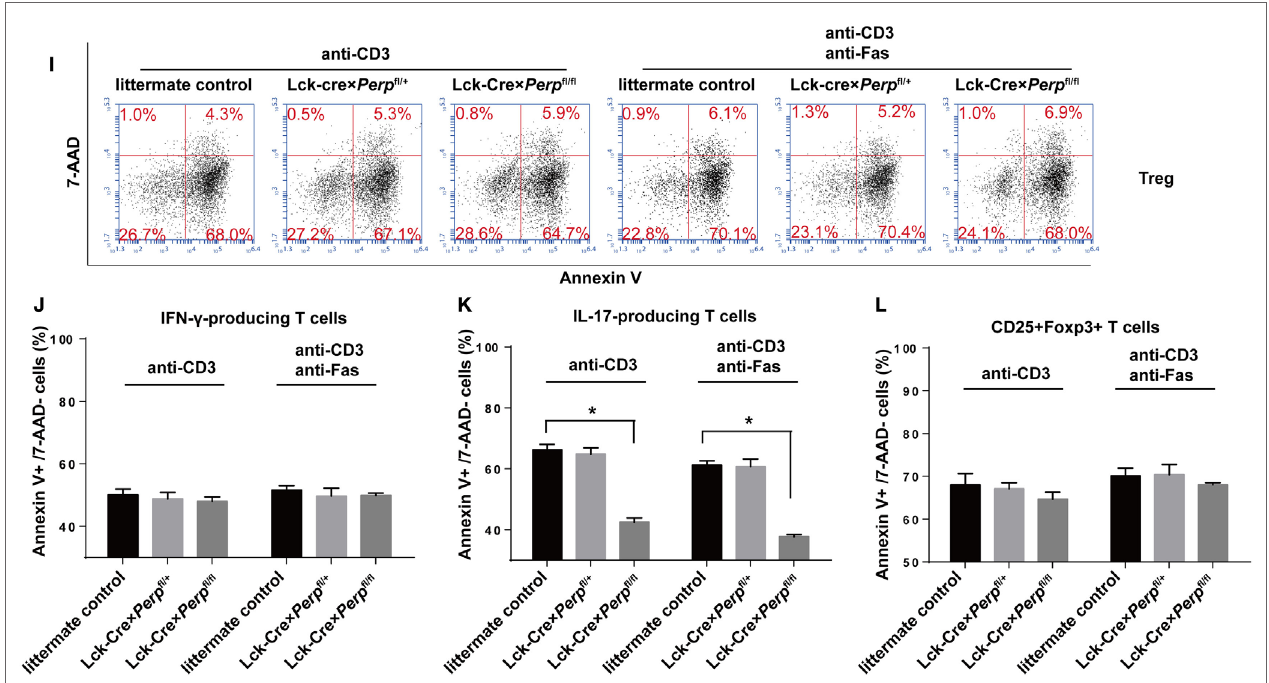
FigUre 2 | Perp − / − in T cells promotes the resistance to apoptosis in T helper 17 (Th17) cells. CD4 + T cells were isolated from littermate control , Lck-Cre × Perp fl/ + and Lck-Cre × Perp fl/fl mice by negative selection and stimulated with anti-CD3/anti-CD28 in the presence of cocktail of cytokines and antibodies to induce Th1, Th17, or Treg cell differentiation for 3 days. The cells were stained with anti-CD4 and/or anti-CD25, fixed, permeabilized, and intracellularly stained with anti-IFN- γ , anti-IL-17A, or anti-Foxp3. The frequency of Th1, Th17, or Treg cells was determined by FACS. Furthermore, following in vitro differentiation for 3 days, the cells were re-stimulated with anti-CD3/anti-CD28 in the presence or absence of anti-Fas for 72 h. The percentages of apoptotic Th1, Th17, or Treg cells were determined by FACS using Annexin V-PE and 7-AAD staining. Data are representative images or expressed as the mean ± SEM of each group from three separate experiments. (a,B) Th1 cell differentiation. (c,D) Th17 cell differentiation. (e,F) Treg cell differentiation. (g,J) Th1 cell apoptosis. (h,K) Th17 cell apoptosis. (i,l) Th17 cell apoptosis (* P <